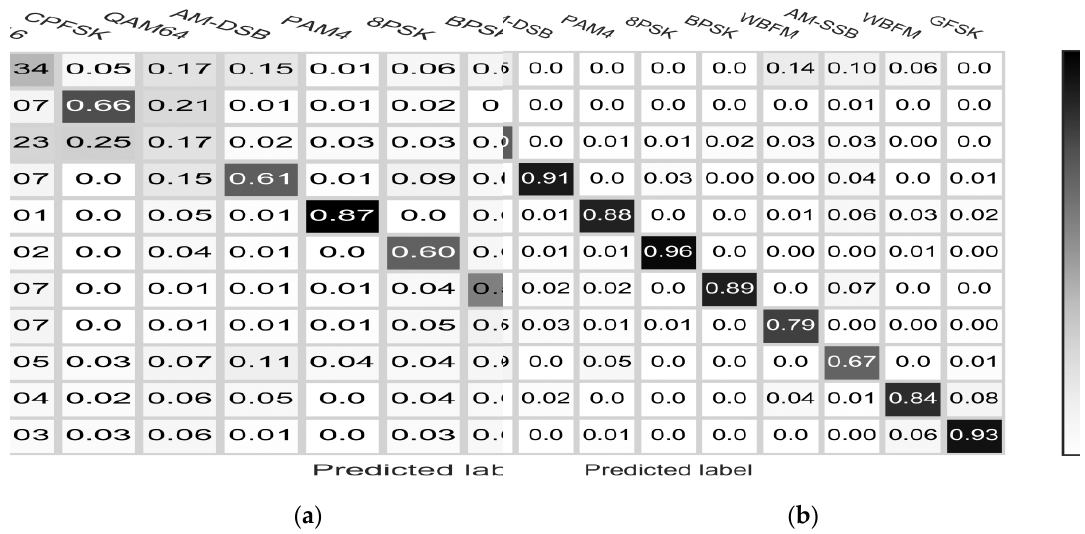
Figure 6. Correct recognition percentages versus SNR for all types of modulation signals.